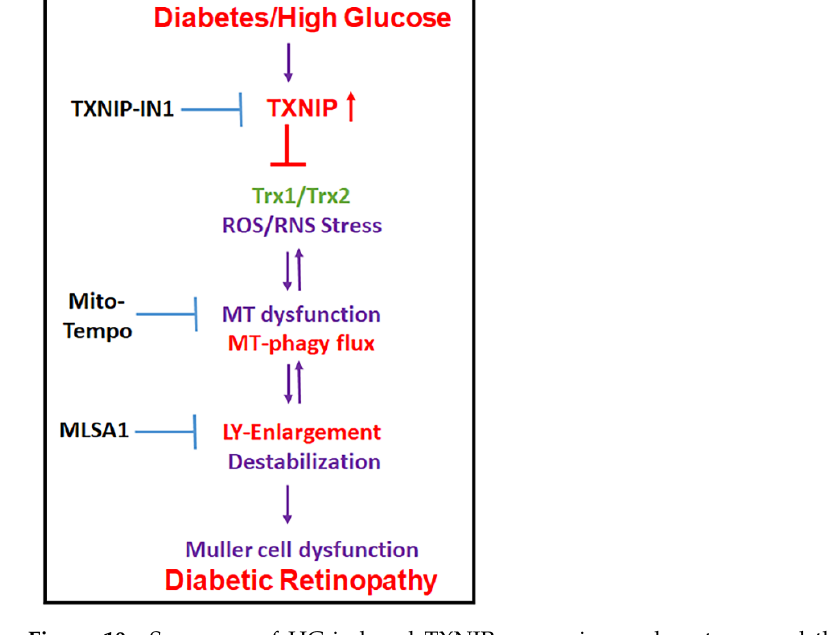
Figure 10. Summary of HG-induced TXNIP expression, redox stress, and the mitochondrial–lysosomal axis dysregulation in Müller cells. A potential therapeutic approach for targeting multiple steps at the cellular stress and organelle damage in the pathogenesis of DR. TXNIP-IN1, an inhibitor of the TXNIP-Trx interaction, Mito-Tempo, a mitochondrial matrix-specific superoxide scavenger, and ML-SA1, an agonist of the mucolipin transient receptor potential calcium channel 1 (MCOLN1/TRPML1), description in Discussion.